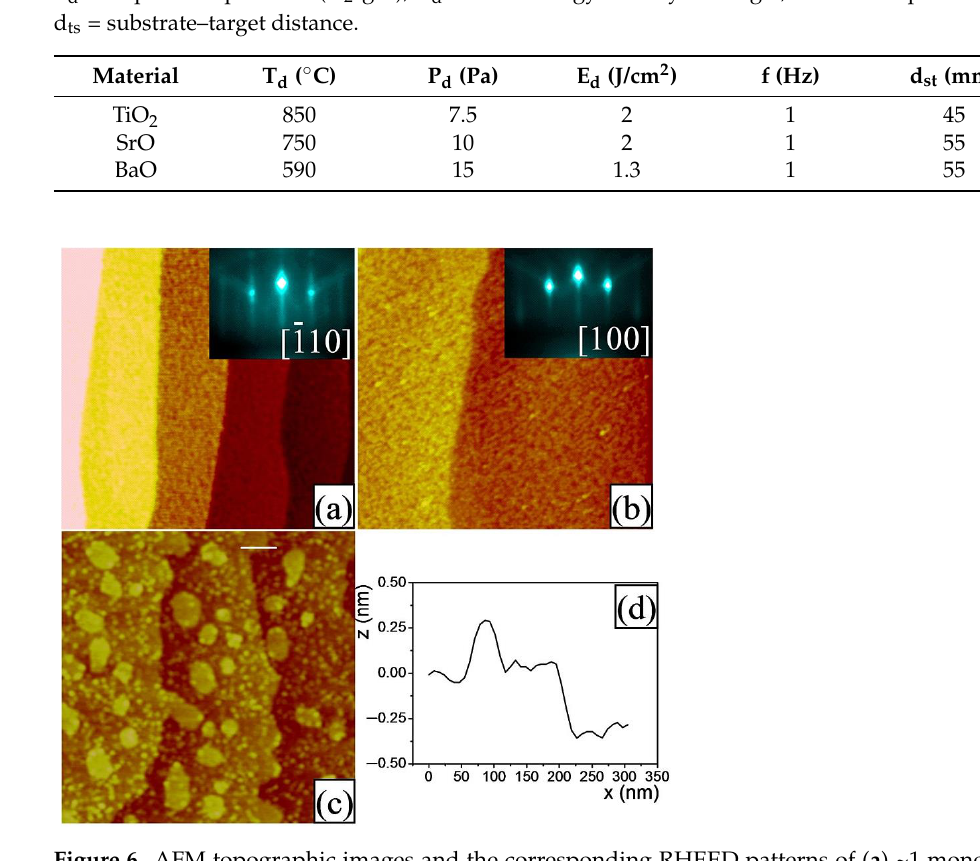
Figure 6. AFM topographic images and the corresponding RHEED patterns of ( a ) ~1 monolayer TiO 2 deposited on (110) NdGaO 3 substrate annealed for 1 h at 1000 °C in O 2 flow (50 L/h); ( b ) ~1 monolayer SrO deposited on (001) NdGaO 3 substrate chemically etched in m-BHF solution and then annealed for 2 h at 1000 °C, in O 2 flow (200 L/h); ( c ) SrO (the same amount of material as in ( b )) deposited on (001) NdGaO 3 substrate annealed for 2 h at 1000 °C, in O 2 flow (200 L/h); SrO islands of about 0.26 nm height formed in this case on substrate terraces (c pc height), as shown by the line scan from ( d ). AFM scan size: ( a ) 1.5 × 1.5 μm 2 , ( b ) 0.75 × 0.75 μm 2 , and ( c ) 2 × 2 μm 2 . SrO was next deposited on an m-BHF etched (001) NdGaO 3 surface. The RHEED specular intensity exhibited clear oscillatory behavior, with the deposition being stopped